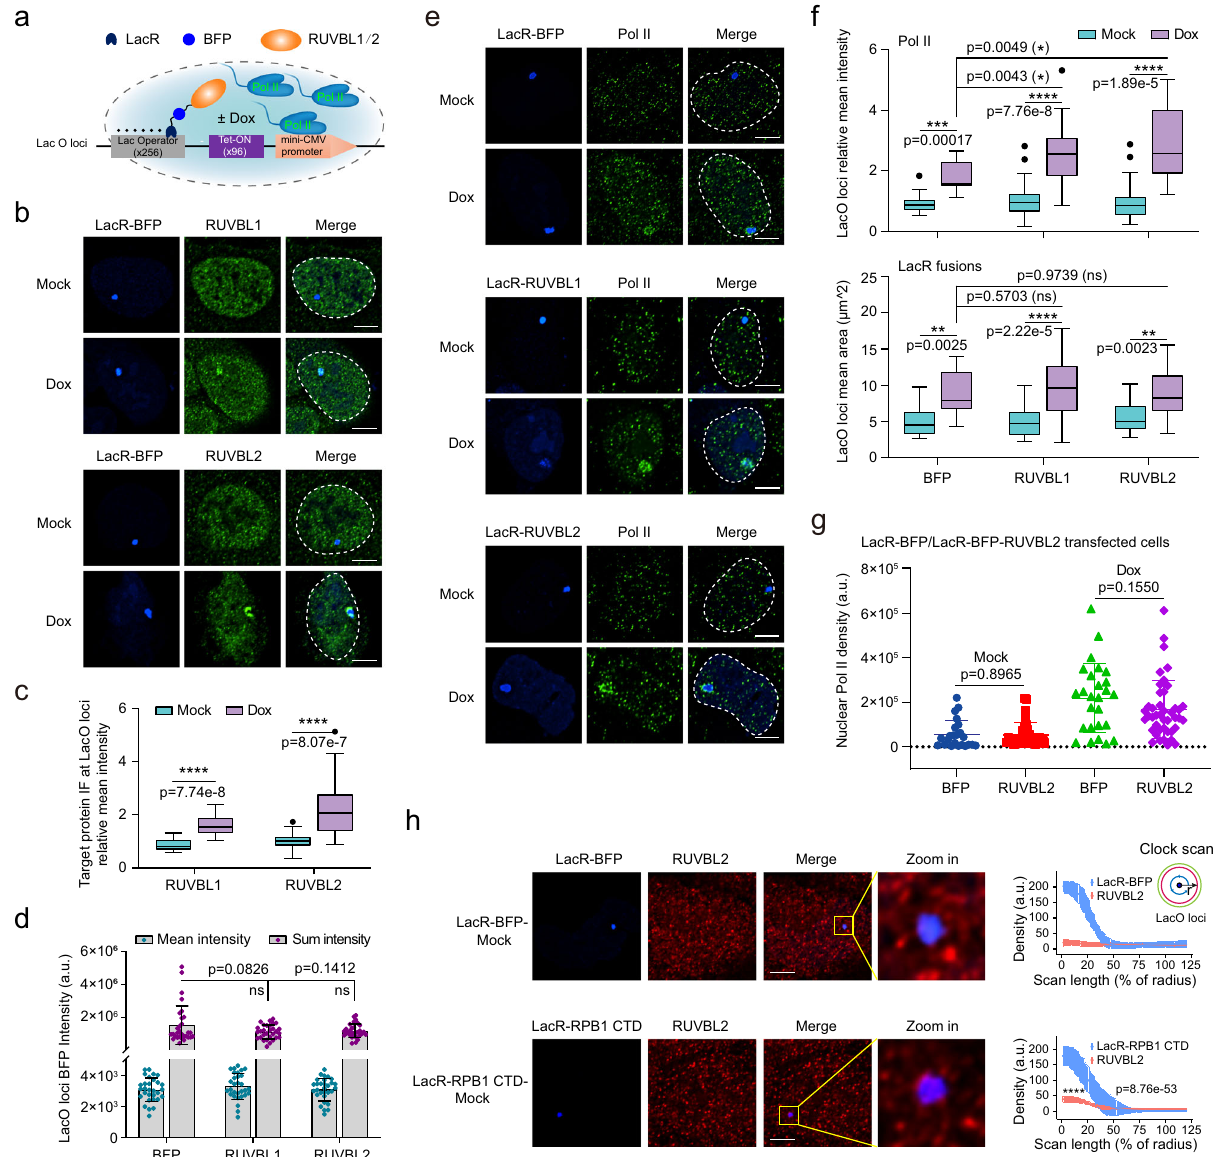
Fig. 4 | Tethering RUVBL2 to an active gene promoter enhances Pol II cluster formation. a Schematic showing the system used for simultaneous imaging of tethered proteins and recruited proteins, as published previously 60 . b Representative images of endogenous RUVBL1 and RUVBL2. Scale bar, 5 μ m. c TherelativeIFsignalsofthetargetproteinsattheLacOlociundermock(RUVBL1 n =24, RUVBL2 n =30) and Dox treatments (RUVBL1 n =18, RUVBL2 n =30). Box plotsindicatemedian(middleline),25thand75thpercentile(box)and5thand95th percentile (whiskers), as well as outliers (single black points), differences between groups were analyzed by two-tailed Student ’ s t tests (**** p <0.0001). d The mean and total intensity of LacR-BFP fusion signals at LacO loci per cell were plotted in bar graphs. The cotransfected cells ( n =30) in different fi elds from 3 transfection replicates wereusedforquanti fi cation. Differencesbetween groupswereanalyzed by two-tailed Student ’ s t tests. “ ns ” indicates no signi fi cant difference. The error bars indicate mean+/ − SDs. e Representative images of endogenous Pol II before